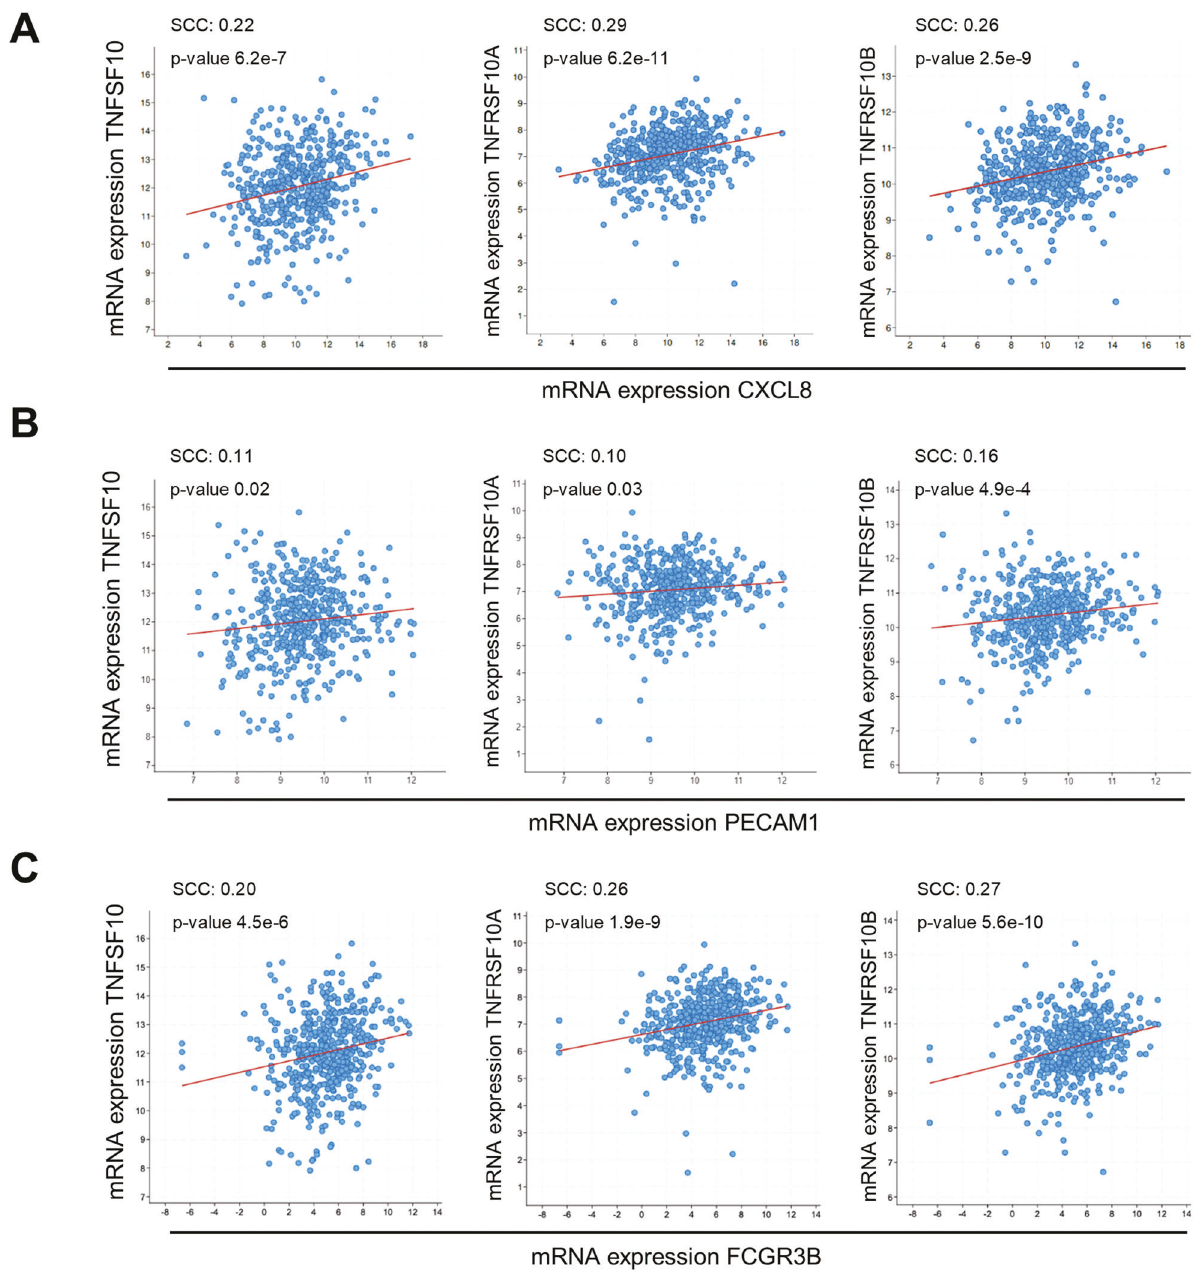
Fig. 7 TRAIL receptors correlate with, IL-8, angiogenesis and neutrophil expression markers in Human lung squamous cell carcinoma. A Correlation data for TRAIL (TNSFSF10), DR4 (TNFRSF10A), and DR5 (TNFRSF10B) versus IL-8 (CXCL8) log2 mRNA expression are shown. mRNA expression z-scores relative to all samples of the Lung Squamous Cell Carcinoma (LUSC) TCGA, Firehose Legacy dataset was used. The statistical signi fi cance was determined using the Spearman Correlation Coef fi cient (SCC) in cBioportal online software. B Same as A but compared to the angiogenesis marker CD31 (PECAM-1). C Same as A but compared to the neutrophil marker CD16b